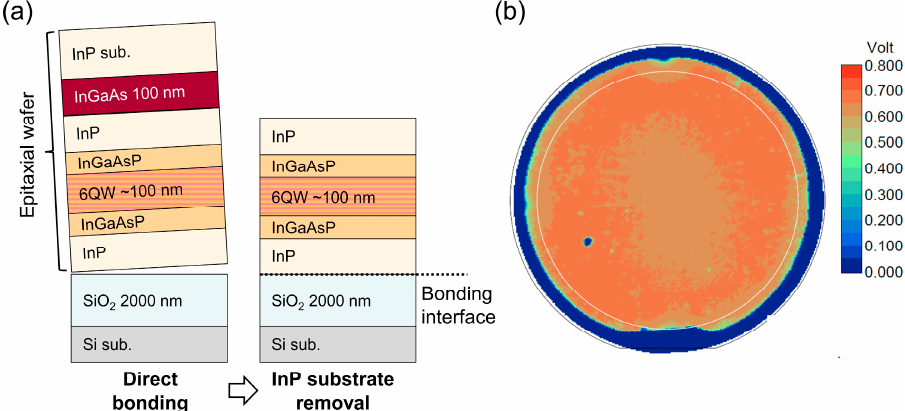
Figure 3. ( a ) Process flow of fabricating a multi-quantum well (MQW)-double-heterostructure (DH) on SiO 2 /Si substrate; ( b ) photoluminescence (PL) intensity map for 2-inch 250-nm-thick MQW-DH transferred to SiO 2 /Si